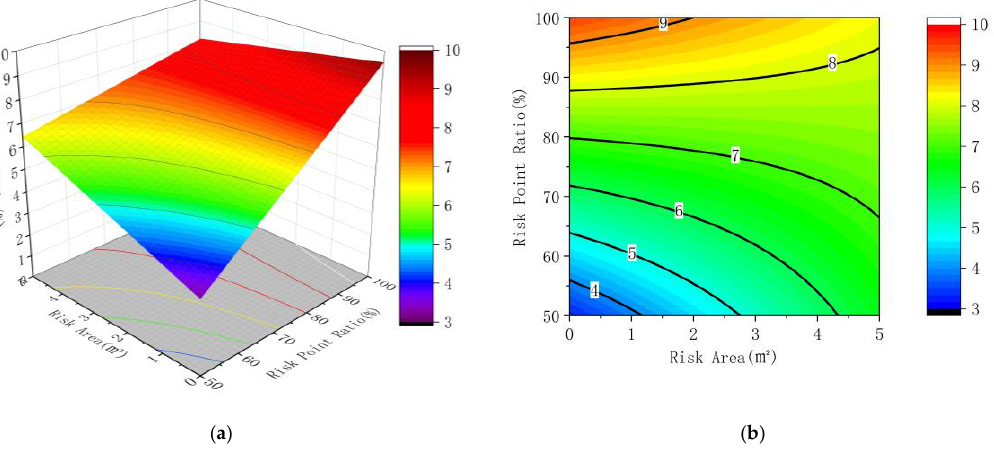
Figure 12. Response surface diagram and contour diagram of the risk point ratio and the risk area to the void ratio; ( a ) the response surface diagram ( b ) the contour diagram.